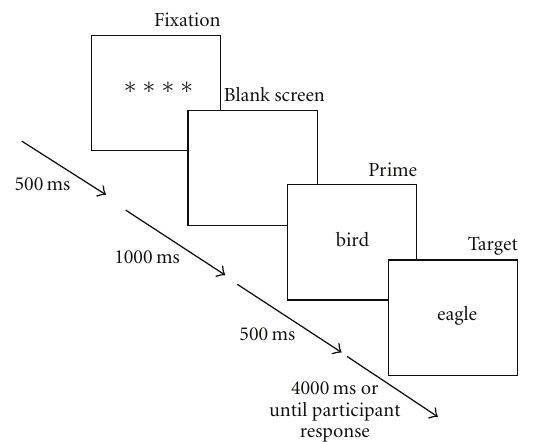
Figure 1: An illustration of the procedure used for a typical trial during the lexical decision